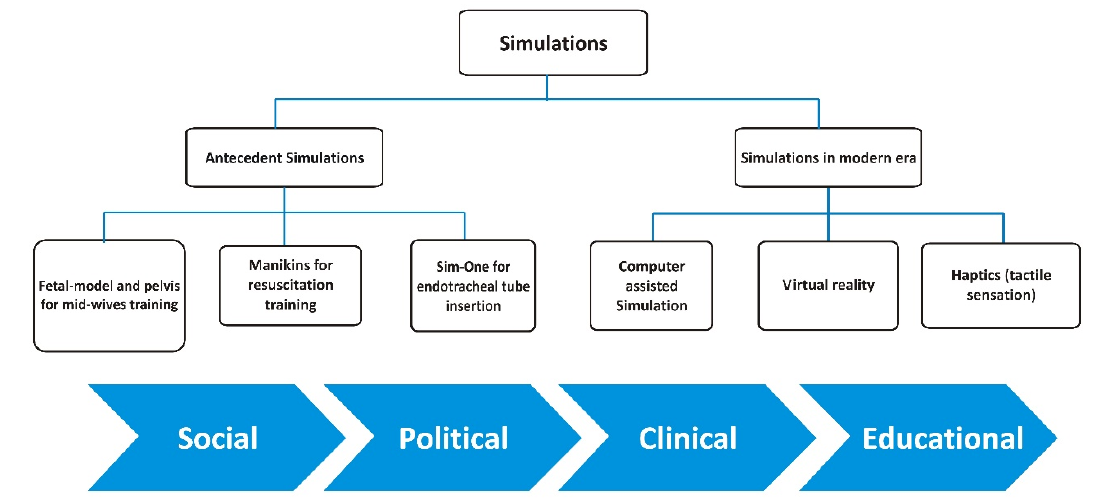
Figure 1. Illustration representing the antecedent simulators along with the modern era simulators.